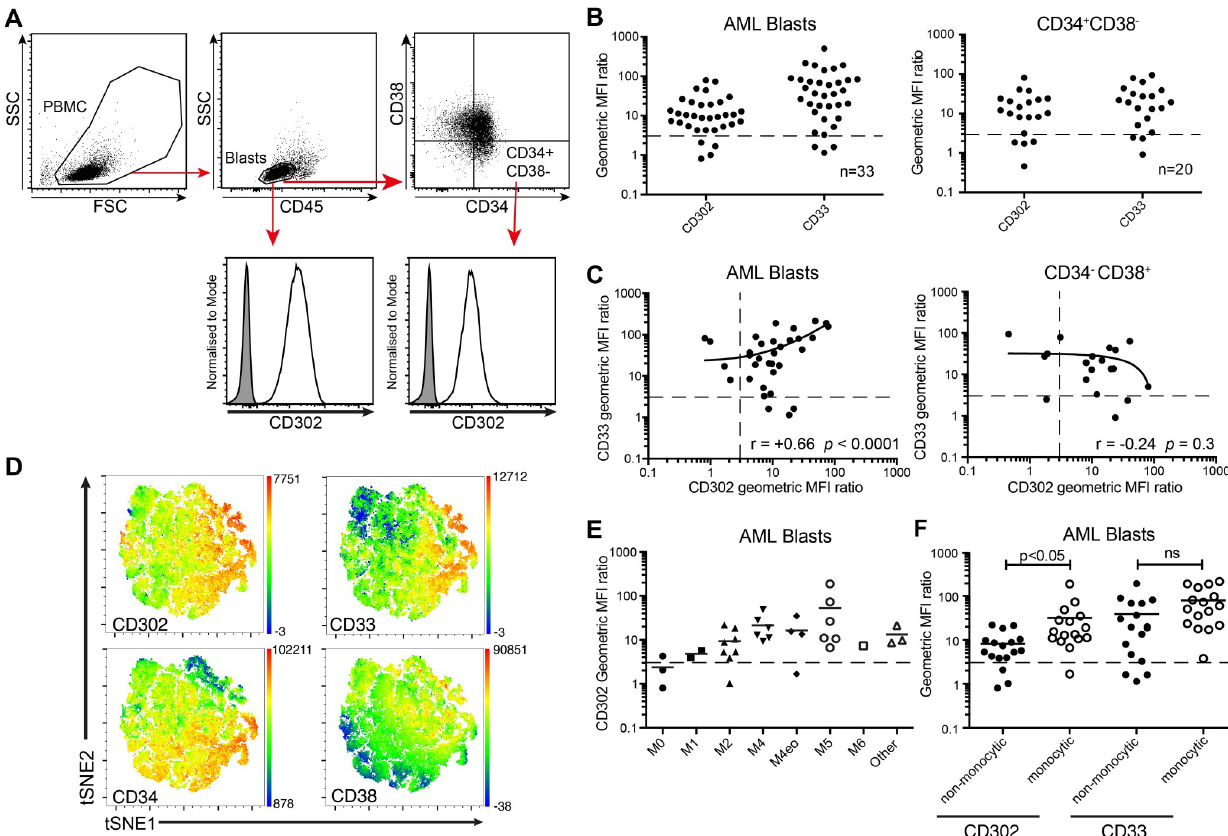
Fig 1. Expression of CD302 on leukemic blasts, CD34 + CD38- LSC and HSC. (A) Gating strategy used to identify CD45 lo SSC lo AML blasts and CD34 + CD38 - LSC. (B) Scatter dot plots showing the CD33 and CD302 expression on AML blasts (n = 33) and LSC fraction (n = 20). Samples were stained with MMRI-20 and CD33 mAb. Populations with a geoMFI ratio � 3, shown above the dotted line, were considered to be positive. (C) Relationship between mean CD33 and CD302 expression on AML blasts and on AML LSC from patients. The solid lines were generated by linear regression. (D) Six parameter data (including CD117, CD34, CD33, CD38, CD45 and CD302) from five concatenated AML patient samples was converted into two t-SNE dimensions and overlayed with heatmaps of the indicated marker’s MFI. (E) Summary of CD302 expression by AML blasts across FAB subtypes based on their morphology and immunophenotypic characteristics, as outlined in the 2008 WHO classification. (F) CD302 and CD33 expression on AML samples with monocytic differentiation, FAB subtype M4 and M5, were compared to other subtypes of AML.